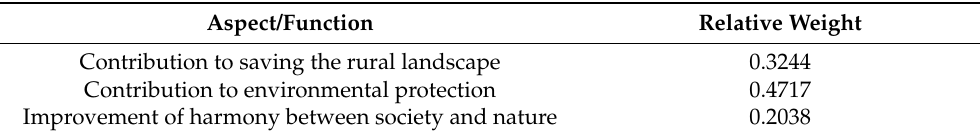
Table 11. Results of the AHP on weighting the relative importance of the environmental dimension of bioenergy